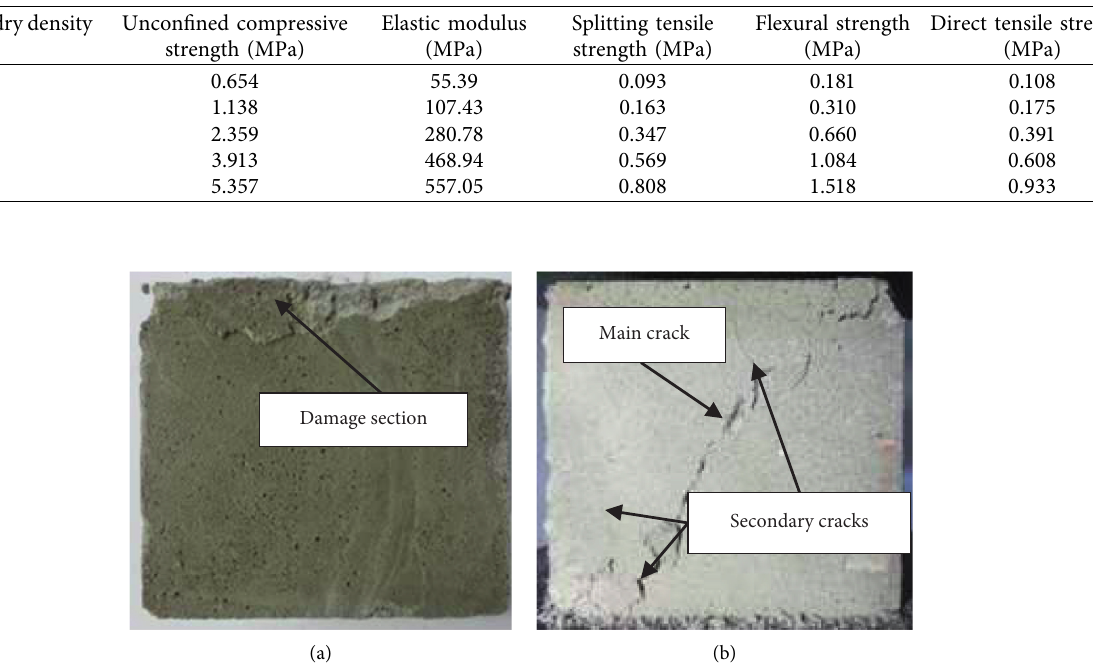
Figure 5: Stress-strain curve of cast-in-situ foamed concrete with different design dry densities.